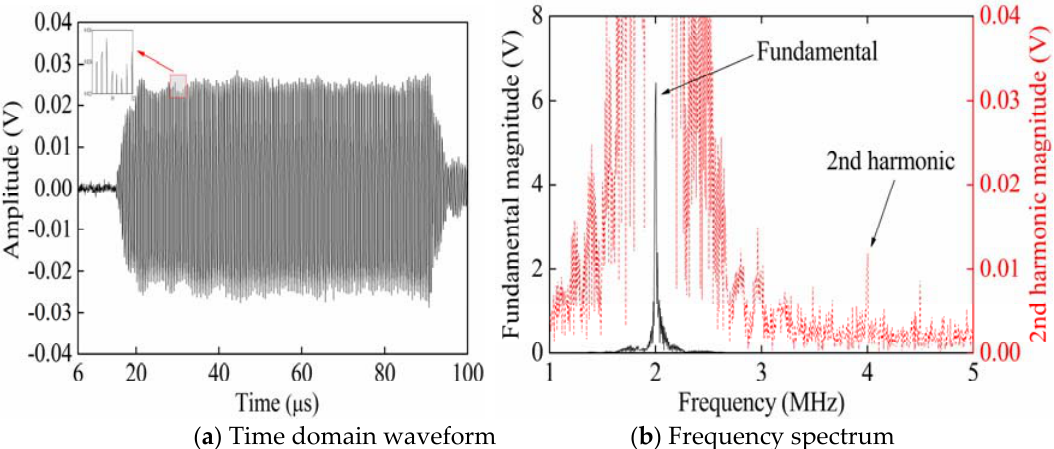
Figure 9. Time domain waveform and frequency spectrum of the received signals when only opening Channel 1.